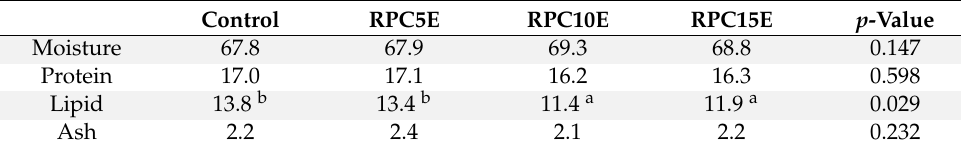
Table 7. Proximate composition (% wet weight basis) of rainbow trout fed experimental diets.